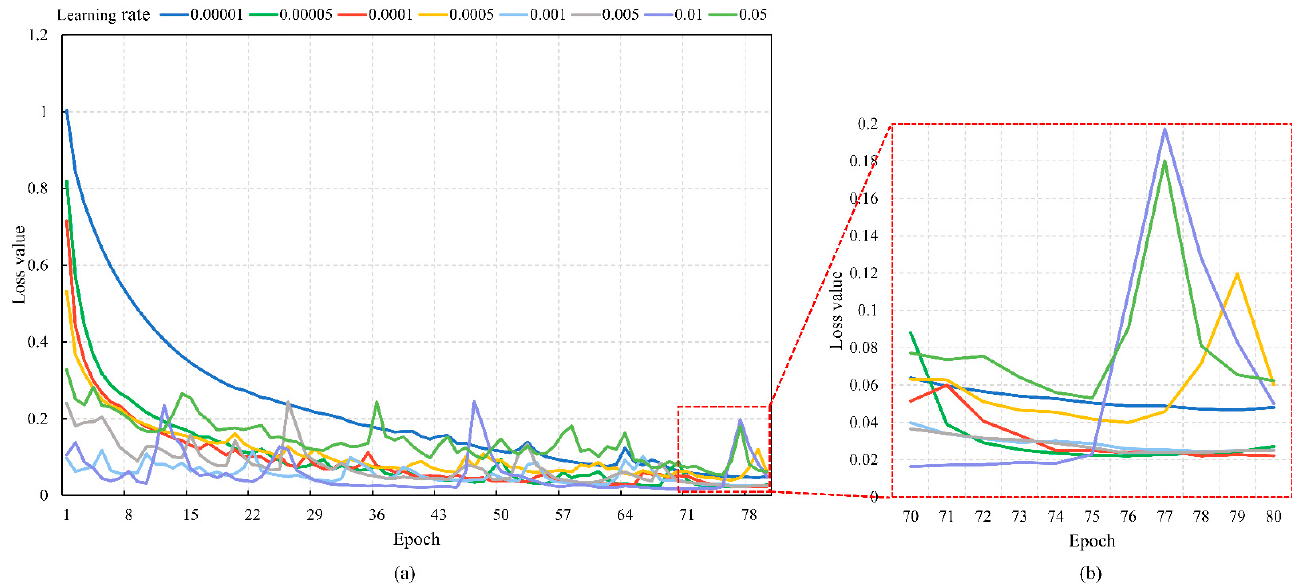
Figure 17. The loss curves of CSD-Net with different learning rates. ( a ) The complete loss curve of CSD-Net during training. ( b ) Partial enlargement of the loss curves in the later stages of training. Table 8. Quantitative evaluation results of CSD-Net with different learning